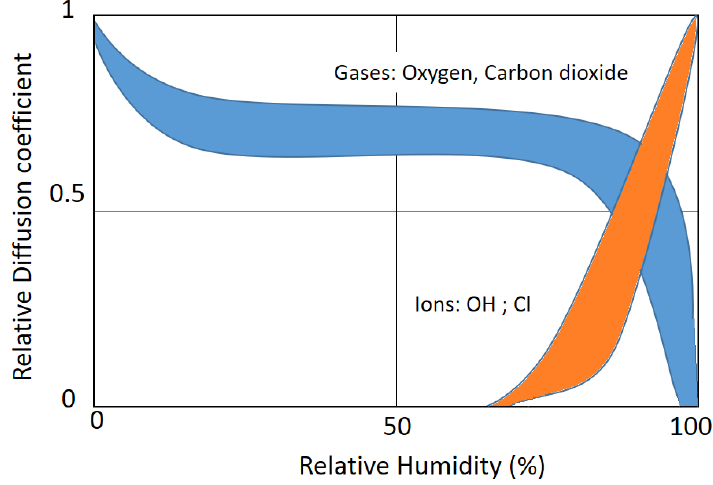
Figure 16. Schematic representation of the diffusion coefficients of ions and gases within a mortar as a function of the relative humidity based on Ref. [38].